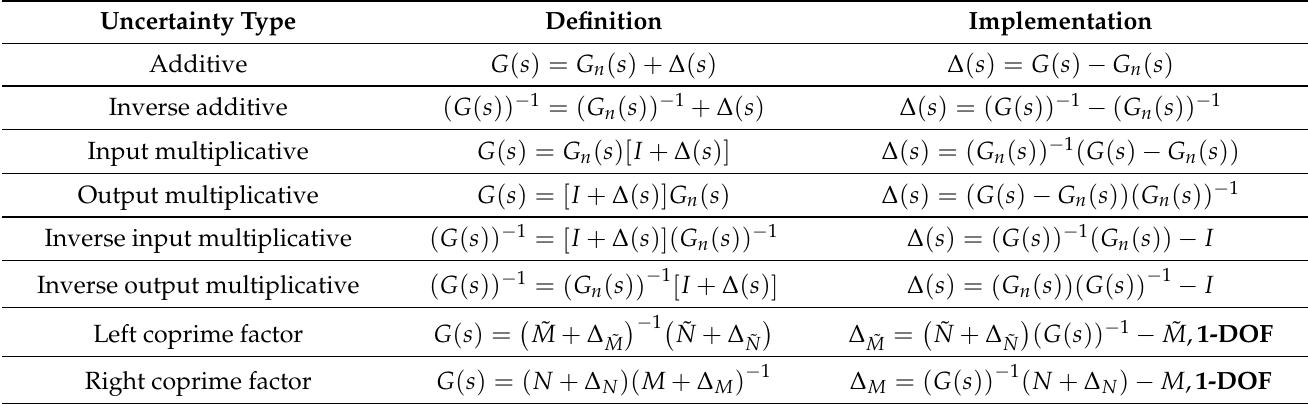
Table 1. Commonly used classes of perturbation and uncertainty models for multiple-input and multiple-output (MIMO) systems, implemented in class UncertainPlantFactory